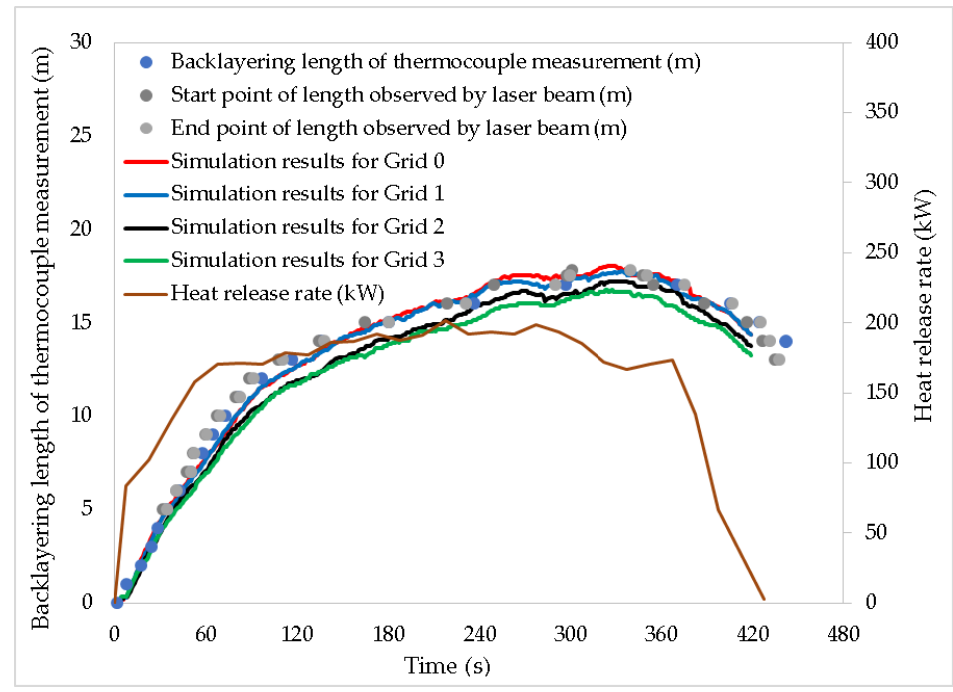
Figure 8. Grid independence test for the simulation. Table 4. Conditions used for the numerical simulation.